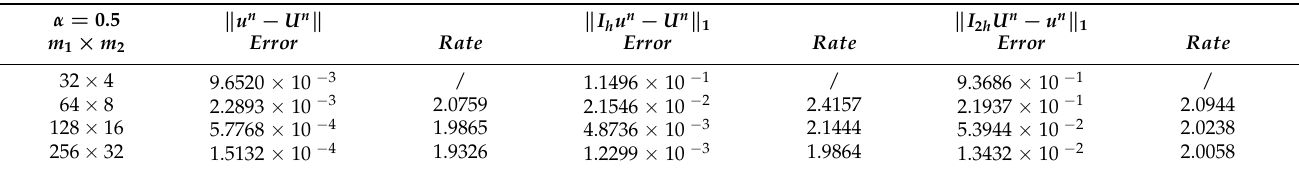
Table 10. Spatial numerical results of (cid:101) = 0.05 on anisotropic meshes to Example 2. α =